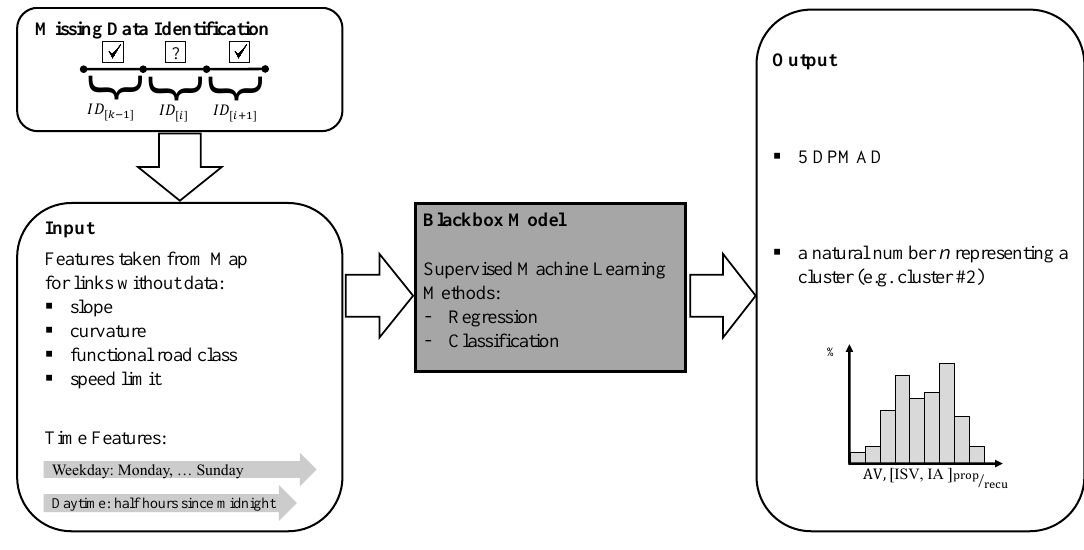
Figure 2. Blackbox